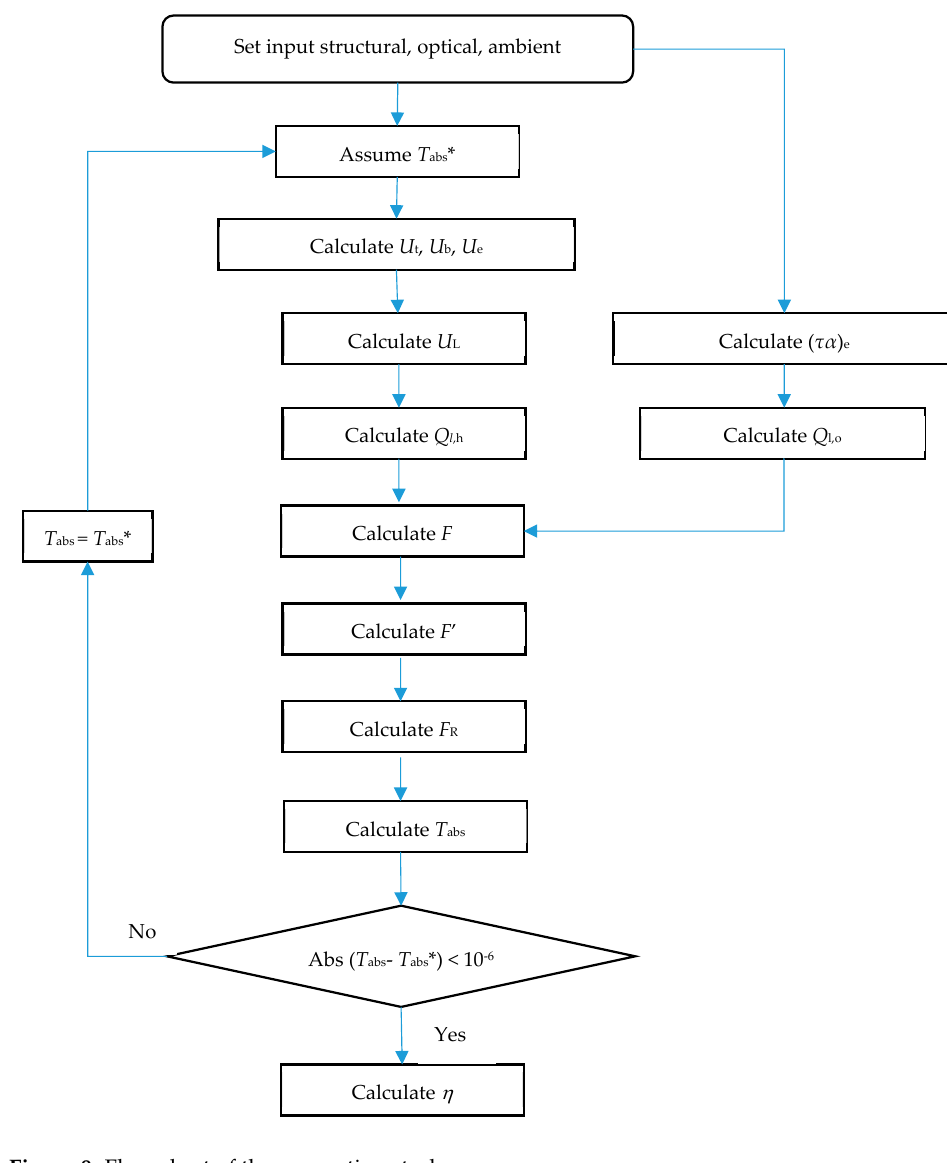
Figure 9. Flow chart of the computing study.